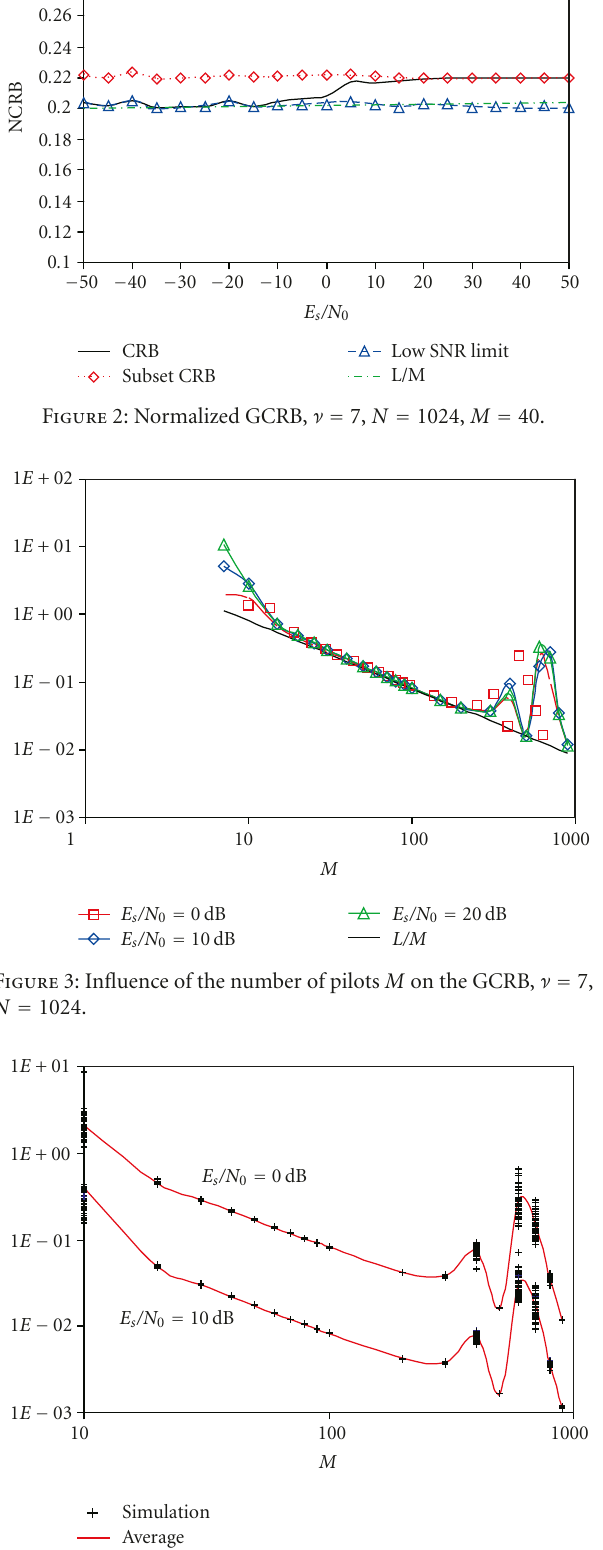
Figure 4: Influence of the pilot sequence on the GCRB, ν = 7, N =